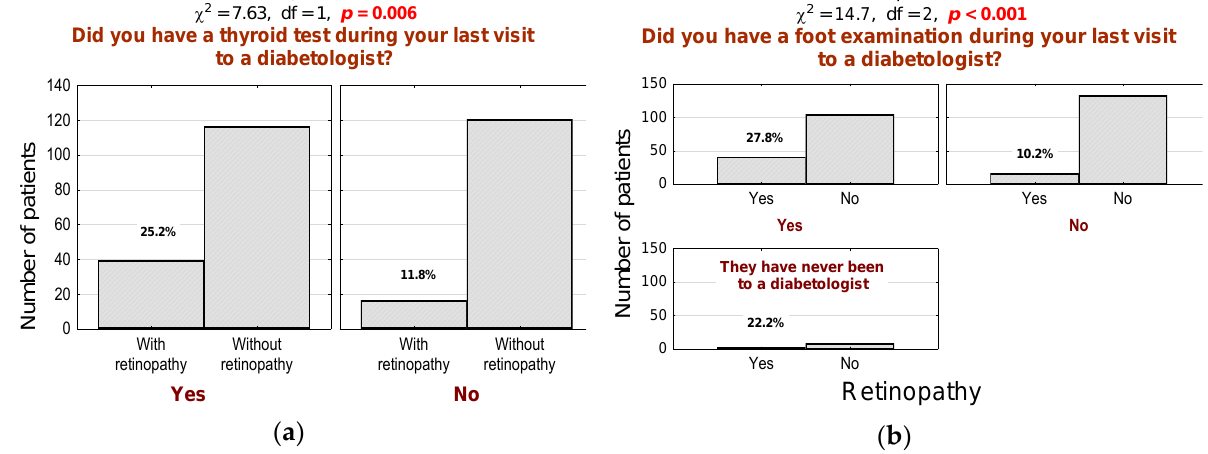
Chi-square test  2 = 14.7, df = 2, p < 0.001